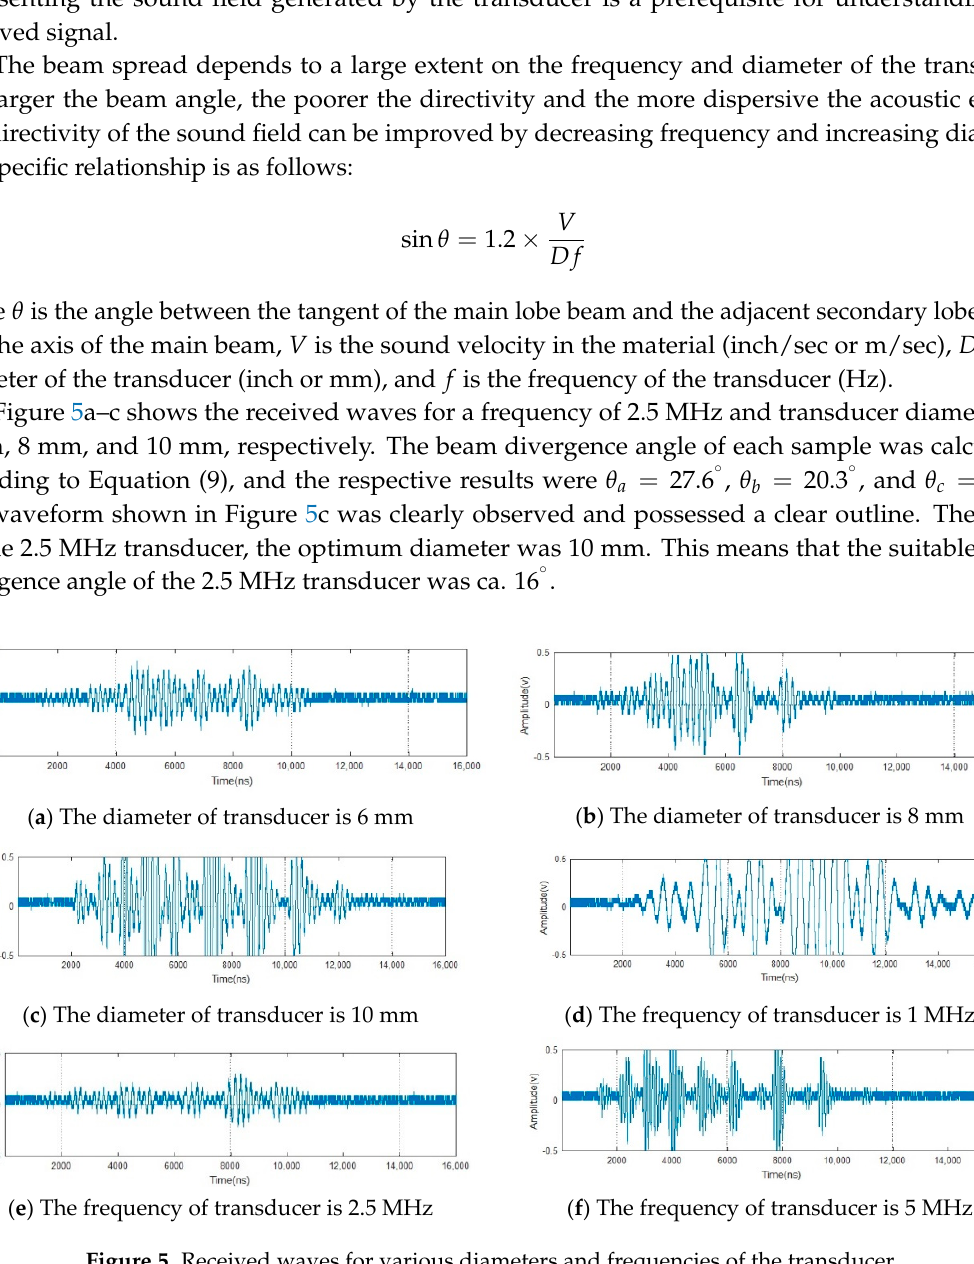
Figure 4. Received waves for different distances between the transmitter and the receiver (test conditions: frequency of transducers: 5 MHz, diameter of transducers: 6 mm. l : the distance between transmitting transducer and the first receiving transducer, 1 L : the first leg, SKD : the skip distance).